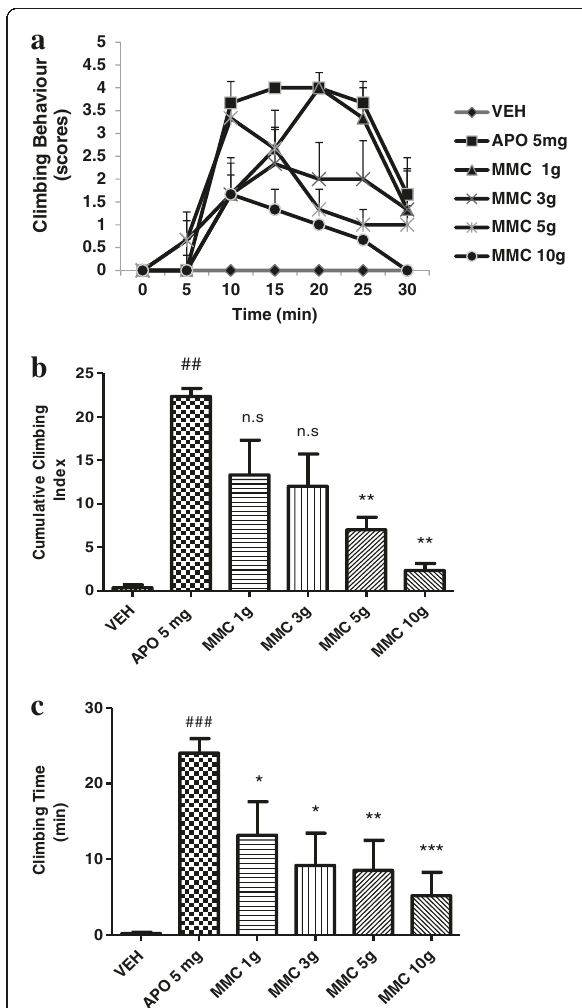
Figure 1 Effect of MMC, (g/kg, p.o) on cage climbing behaviour and climbing time induced by apomorphine in mice. ( a ) Each point represents the mean ± SEM from the scores obtained from six animals. ( b ) The cumulative scores were measured for 30 min after administration of apomorphine. ( c ) Total time spent on the wall of the cage. ### p < 0.001, ## p < 0.01 compared with that of the saline group; * p< 0.05, ** p < 0.01, *** p <0.001 compared with that of the apomorphine (APO, mg/kg, i.p) group. Haloperidol (2 mg/kg, i.p) showed 100% inhibition of apomorphine response (data not shown). n.s- not significant.